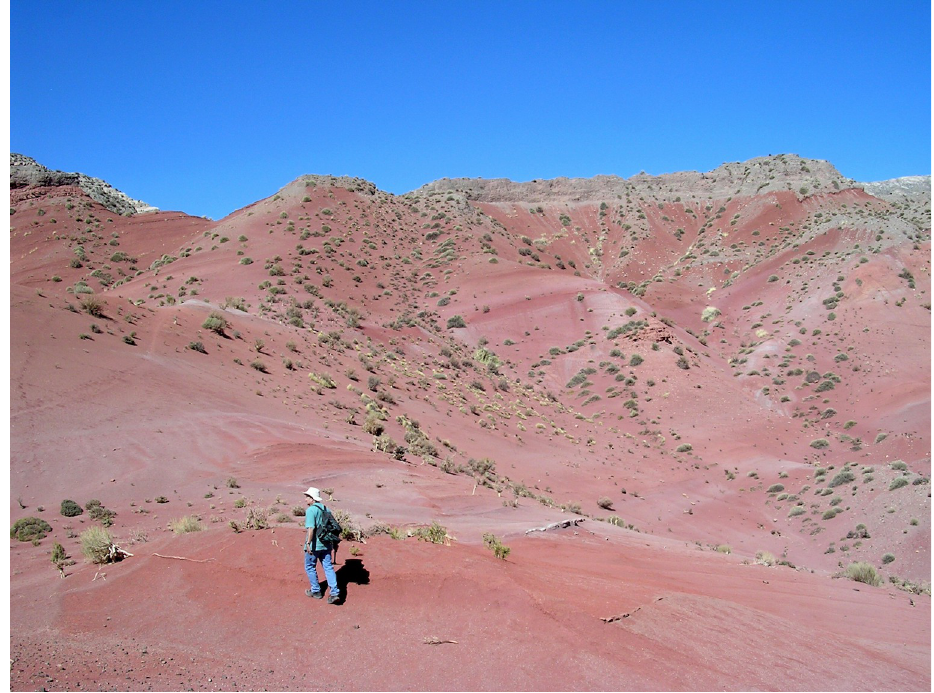
Fig 2. Field aspect of the palynomorph-bearing sediments. Note the overall appearance of the terrestrial deposits cropping out in Jujuy (Casa Grande